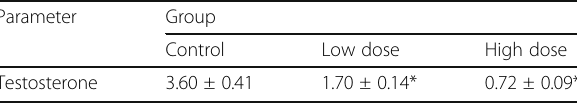
Table 3 The effect of BPA on serum testosterone